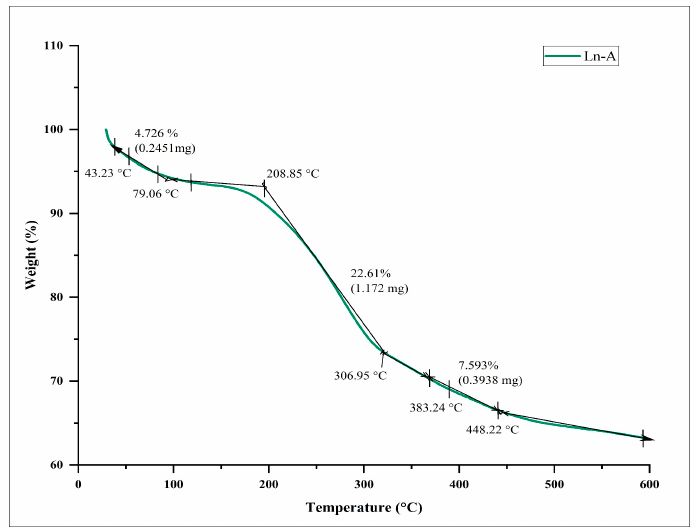
Figure 9. Thermo gravimetric analysis curve of biosynthesized LnFb-AgNPs from L. nepetifolia flower bud extract.